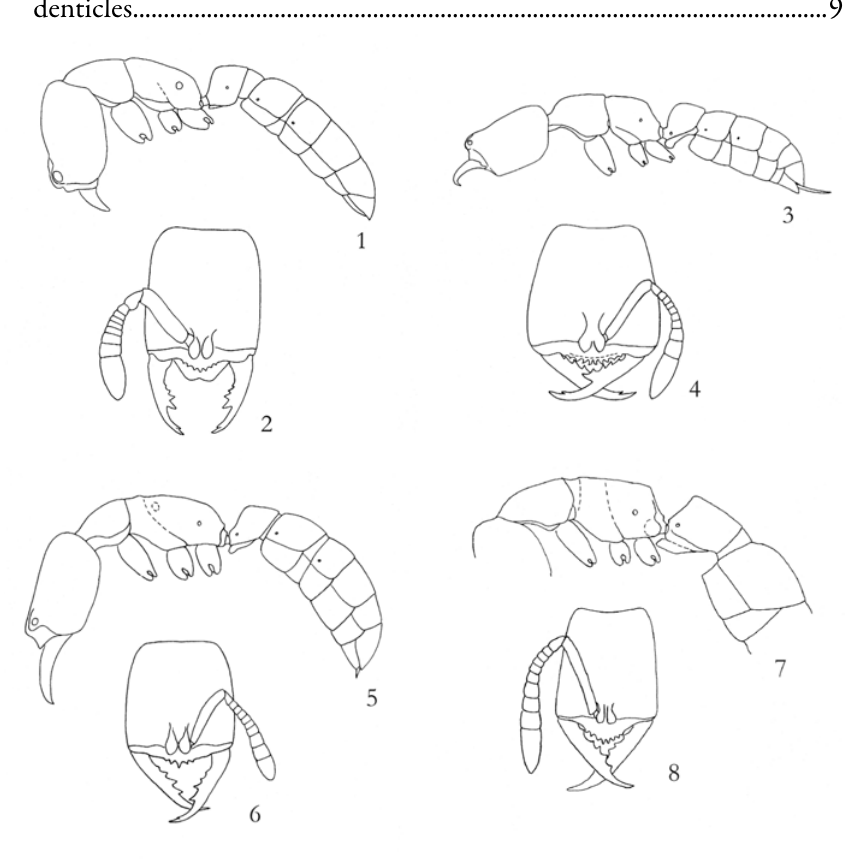
Figs. 1-8. 1-2: Worker of Amblyopone fulvida Terayama. 1. Head and body in profile view; 2. Head in full-face view. (Cited from Terayama 1987, slightly modified) 3-4: Worker of Amblyopone pertinax Baroni Urbani; 3. Head and body in profile view; 4. Head in full-face view. (Cited from Baroni Urbani 1978, slightly modified) 5-6: Worker of Amblyopone caliginosa Onoyama. 5. Head and body in profile view; 6. Head in full-face view. (Cited from Imai et al . 2003, slightly modified) 7-8: Worker of Amblyopone sakaii Terayama; 7. Head and body in profile view; 8. Head in full-face view. (Cited from Terayama 1989, slightly